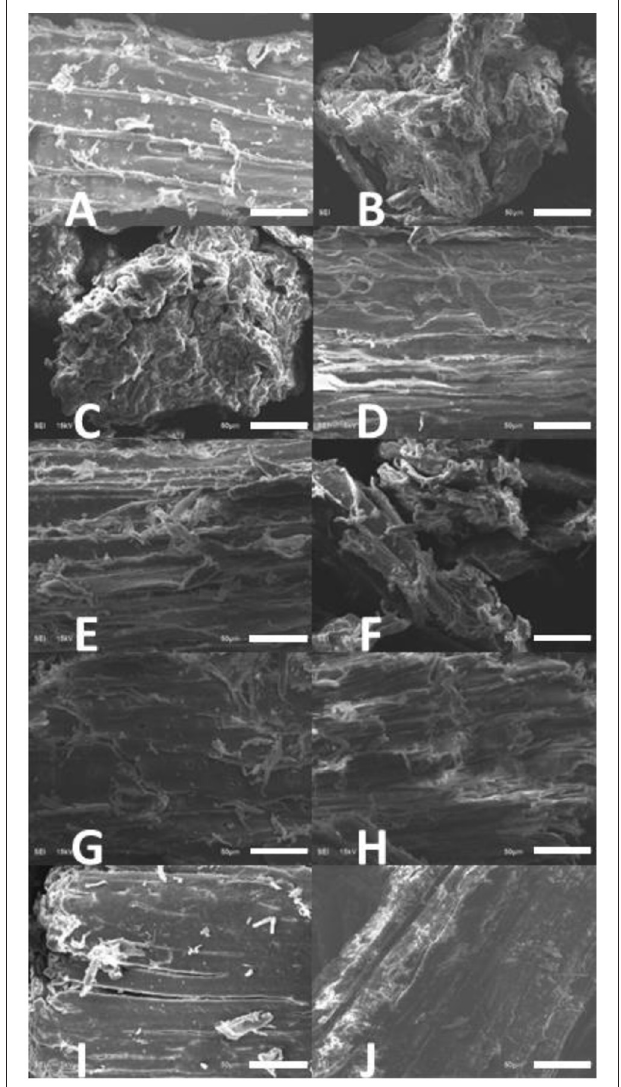
FIGURE 1 | SEM images of IL treated lodgepole pine. (A) Raw pine, (B) EmimAc, (C) EmimCl, (D) BmimCl, (E) AmimCl, (F) BdimCl, (G) MpimI, (H) BmimOTf, (I) BmimBF 4 , and (J) BmimPF 6 . The scale bar in each image is 50 µ